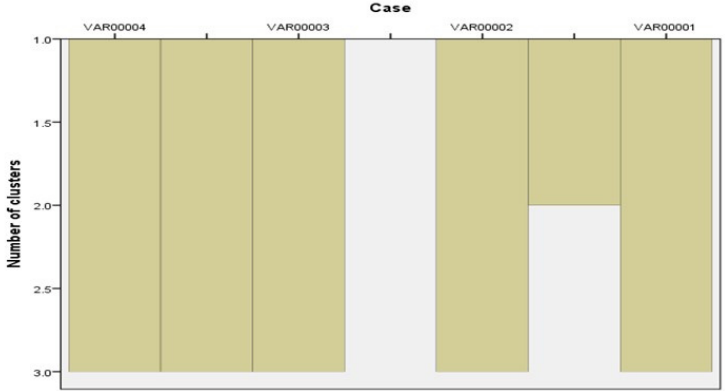
Figure 6. Dendrograms were generated by the unweighted pair group method with arithmetic average (UPGMA) and Ward’s hierarchical clustering routine. Similarity index (Jaccard/Tanimoto coefficient and the number of intersecting elements) between all samples were calculated using the online tool (https://planetcalc.com/1664/, accessed on 21 May 2022).